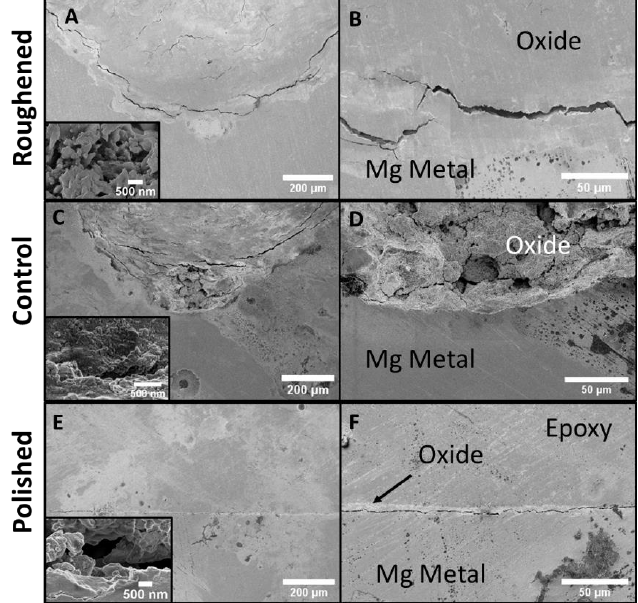
Figure 7. SEM images of the cross-sections for all three samples. ( A ) roughened sample with inset: highest magnification of roughened sample, ( B ) roughened sample higher magnification, ( C ) control sample with inset: highest magnification of control sample, ( D ) control sample higher magnification, ( E ) polished sample with inset: highest magnification of polished sample, and ( F ) polished sample at